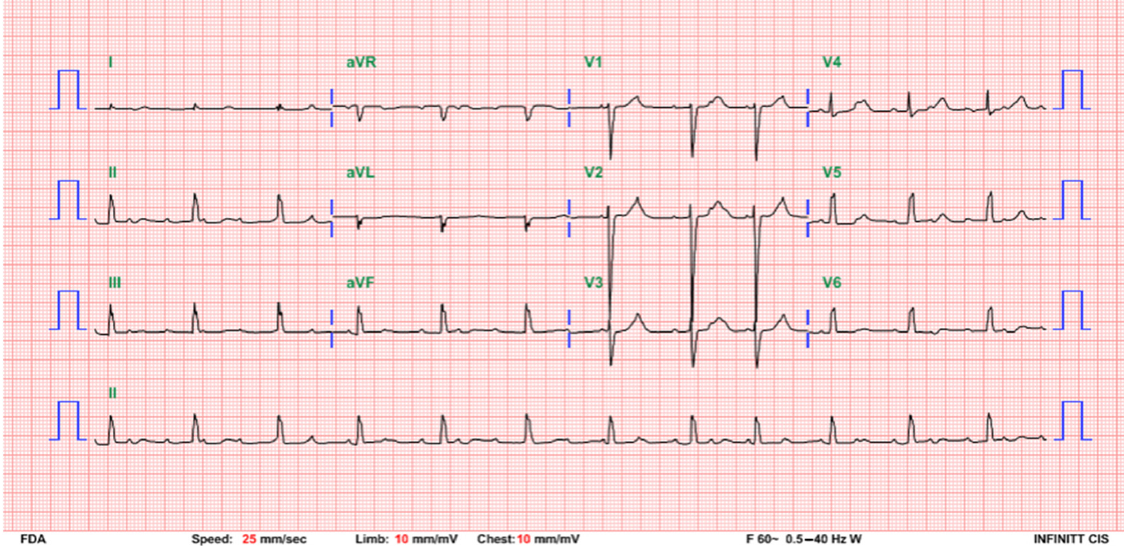
Figure 1. A postdelivery ECG indicating a complete AV block with an atrial rate of 158 beats per minute and a ventricular rate of 75 beats per minute.